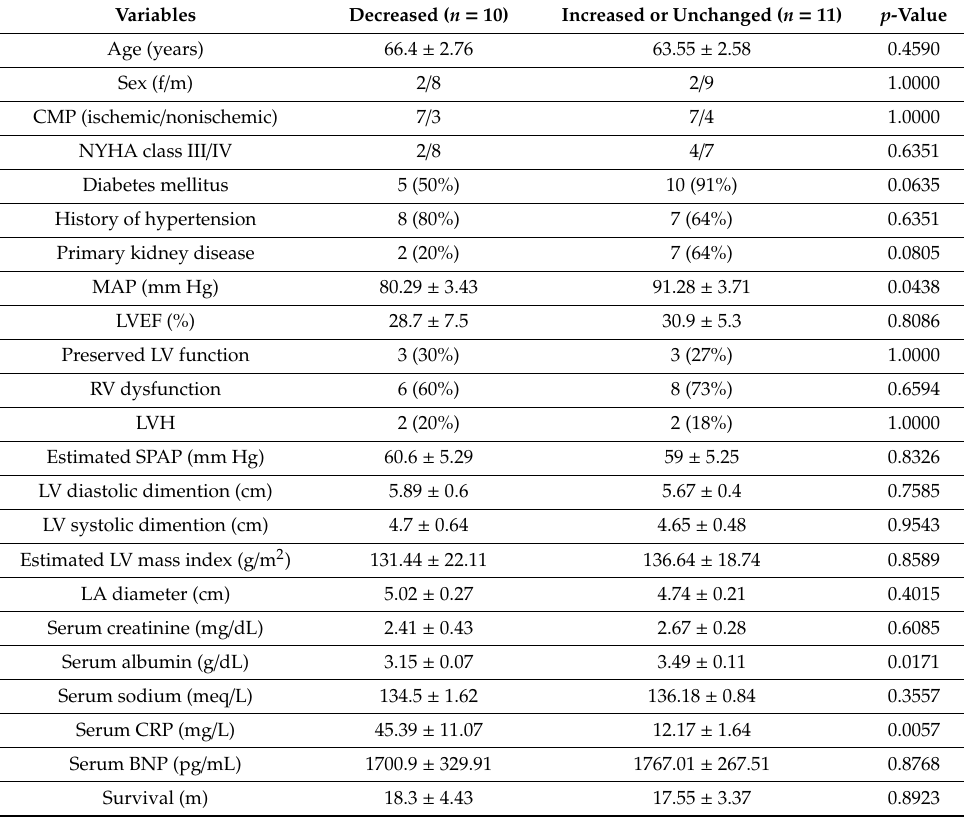
Table 4. Comparison of selected clinical and laboratory parameters of congestive heart failure (CHF) patients whose serum PIIINP decreased after 3 months of PD treatment with parameters of patients whose serum PIIINP increased or did not change ( n =